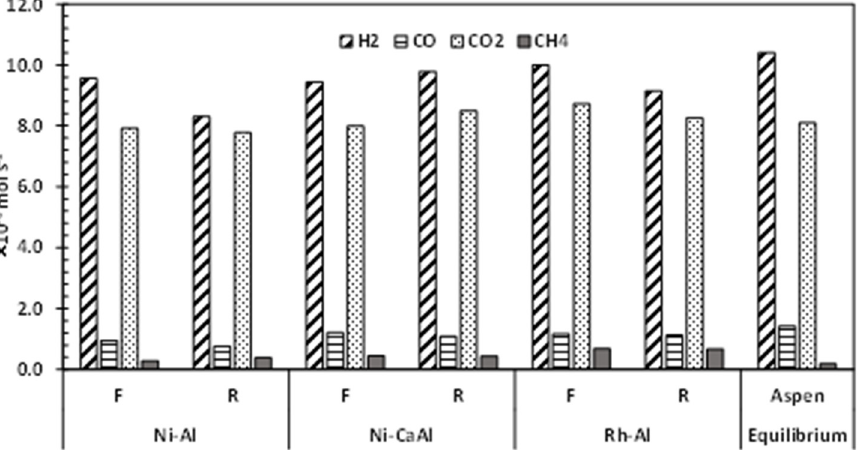
Figure 3. Average nitrogen-free dry product gas composition obtained during ATR of acetic acid flowing at 1 mL/h using Ni-Al, Ni-CaAl and Rh-Al catalyst in fresh (F) and reduced (R) state. S/C = 2, λ = 0.353 (Air flow = 22 mL/min), 570 °C and 1 bar.